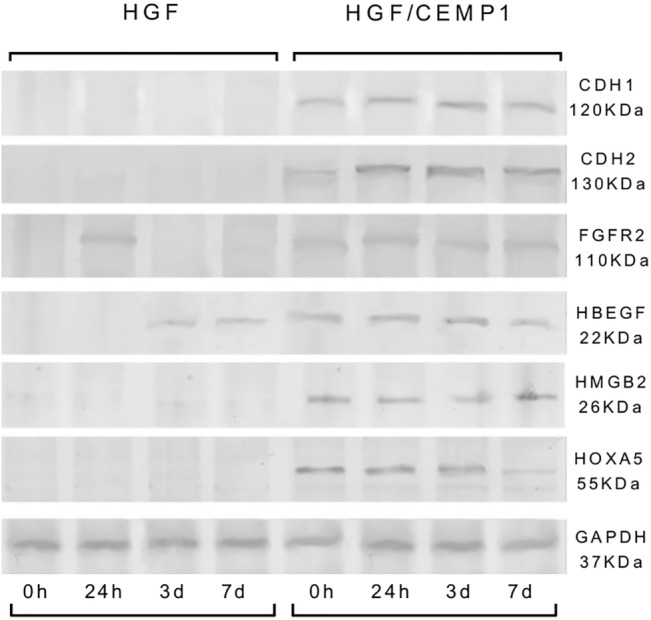
Western Blot validation of microarray results for key genes.Validation at the protein level by Western Blot was made at different time terms (basal, 24 hr, 3, and 7 days). Western blot demonstrated protein expression was higher in CEMP1 expressing cells than in controls.